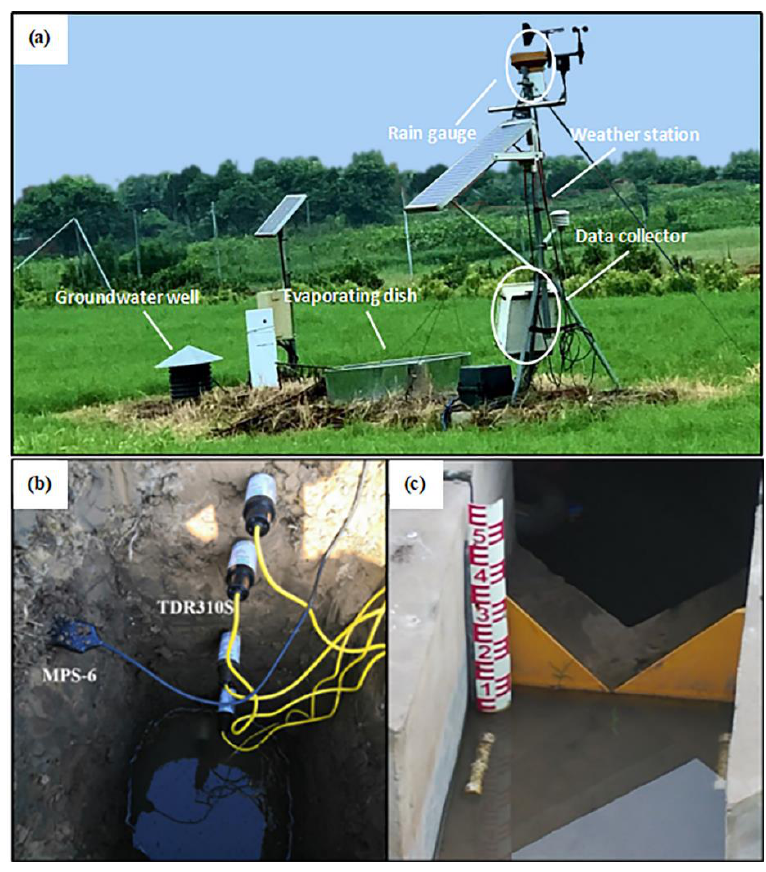
Figure 2. ( a ) Observation instrument in the core test area of BTQ site, ( b ) the soil water profile meas- urement sensors, and ( c ) the V-notch weir at the outlet.